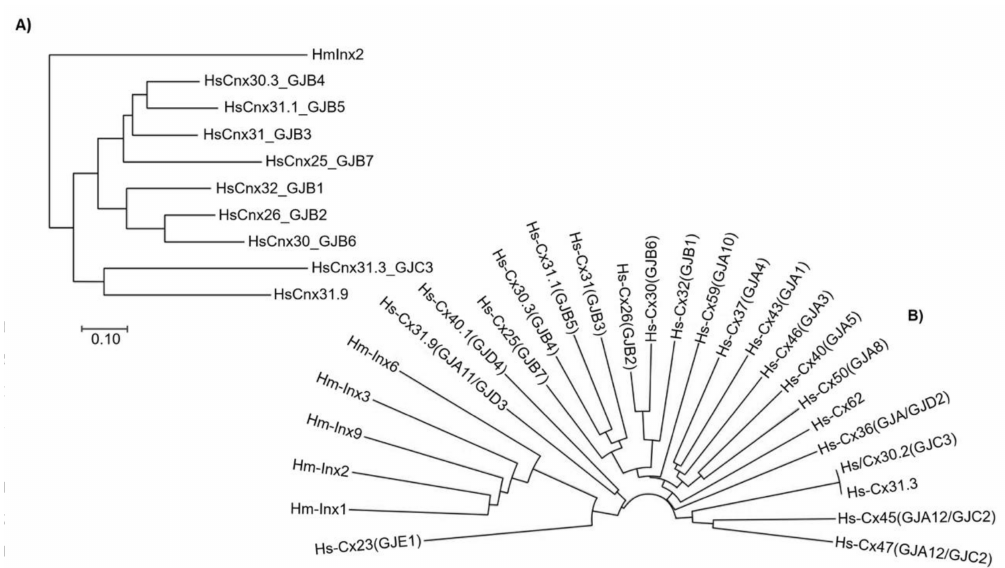
Figure 2. Evolutionary relationships of taxa (protein sequence alignment). Comparing ( A ) HmInx2 vs. human connexins. ( B ) HmInx1, 2, 3, 6, 9, and 14 vs. human connexins. This amino acid